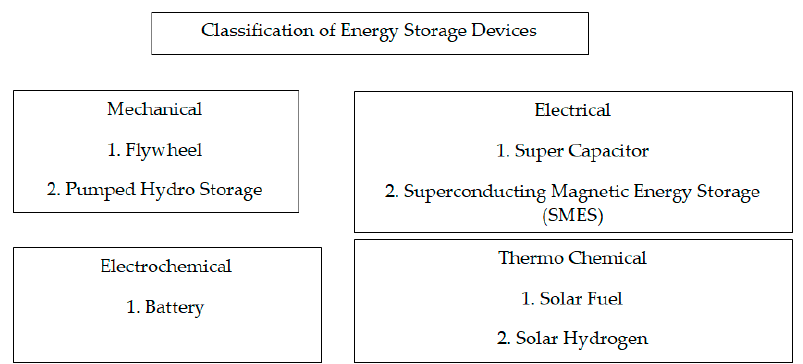
Figure 1. Classification of Energy Storage Devices [1]. Table 1. Comparative analysis of various energy storage devices.